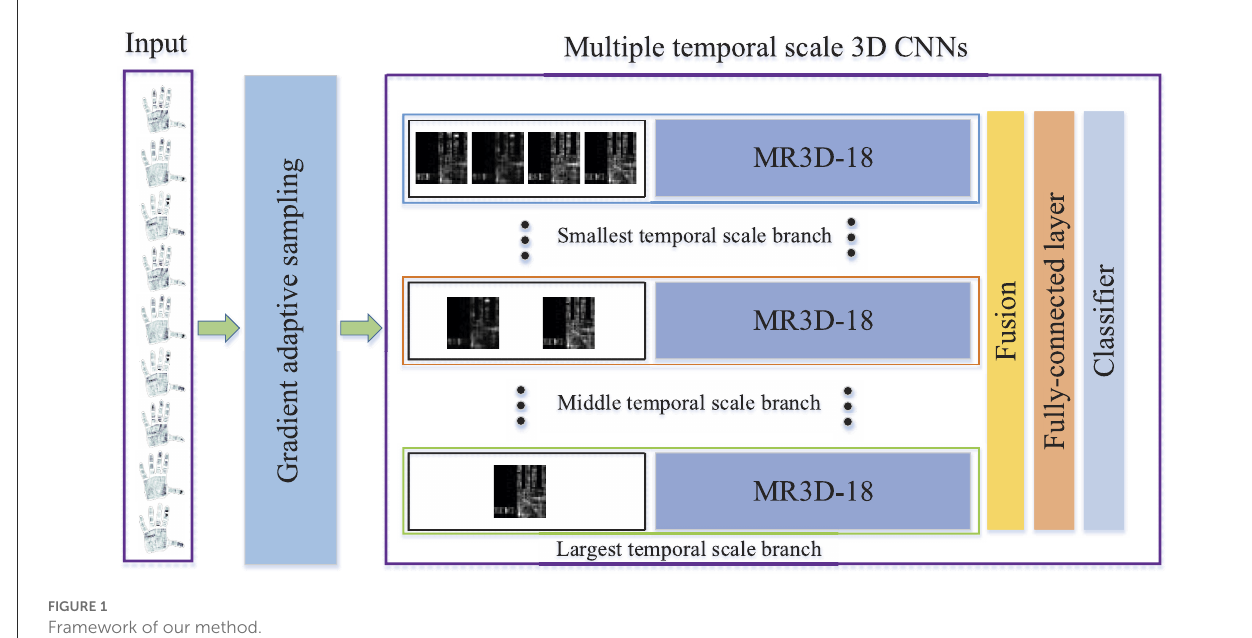
FIGURE1 Framework of our